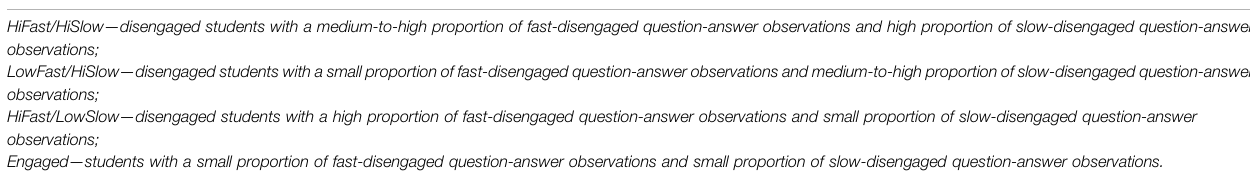
TABLE 3 | Mean and standard deviation (SD) of fast- and slow-disengage proportions for the four clusters of participants in AutoTutor. Cluster of disengagement from DTS 1 (Red): Disengaged- HiFast/HiSlow